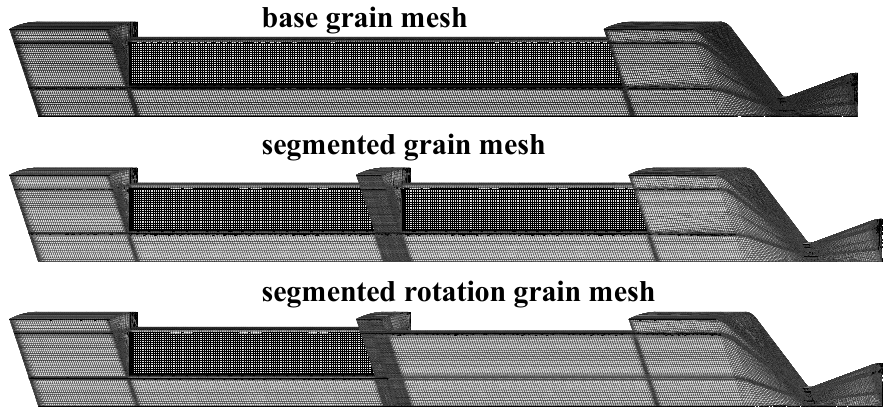
Figure 5. Mesh of the calculation domain in different cases.